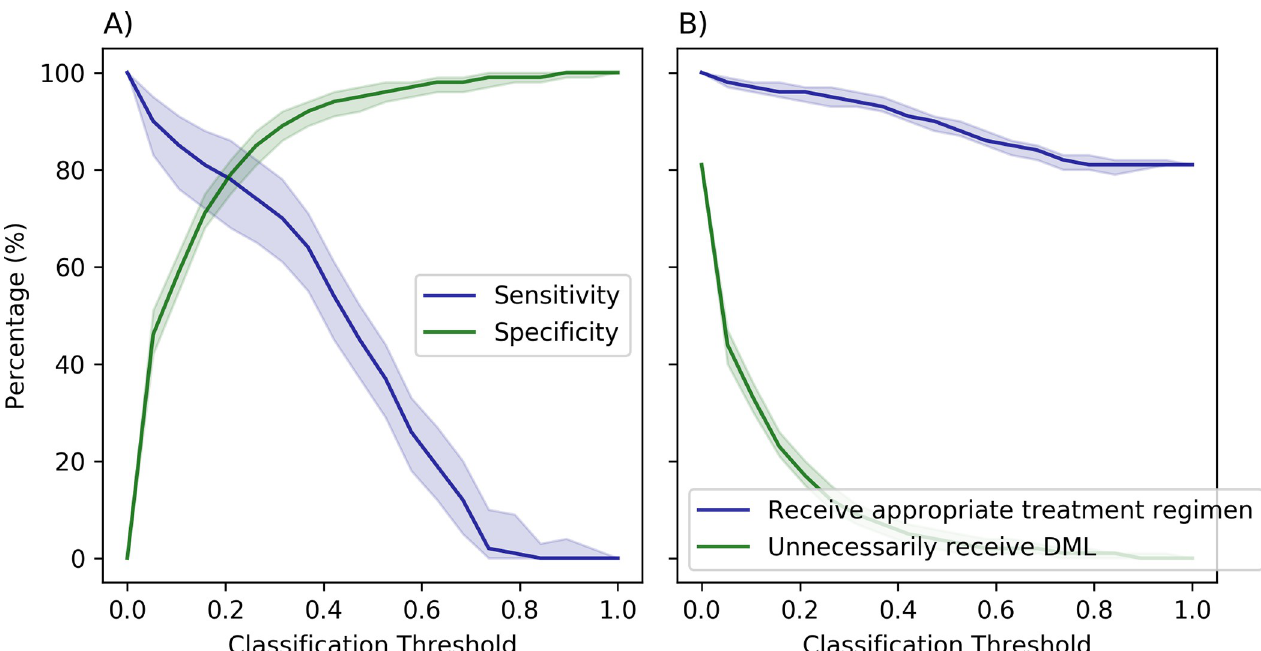
Fig 3. Evaluating the performance of the neural network model that accounts for the local prevalence of resistance to FLQs using features identified by permutation importance for varying classification threshold. The impact of the classification threshold on the optimism-corrected sensitivity and specificity is displayed in Panels A; the impact of the classification threshold on the optimism-corrected proportion of individuals receiving an appropriate treatment regimen (i.e., a regiment that is consistent with susceptibility of a patient’s M . tuberculosis strain to FLQ) and on the optimism-corrected proportion of individuals who are unnecessarily treated with delamanid (DLM) is displayed in Panels B. The regions represent 95% bootstrap confidence intervals. See Figure F in S1 Text for estimates of F1 and Matthews correlation coefficient (MCC) scores for varying classification